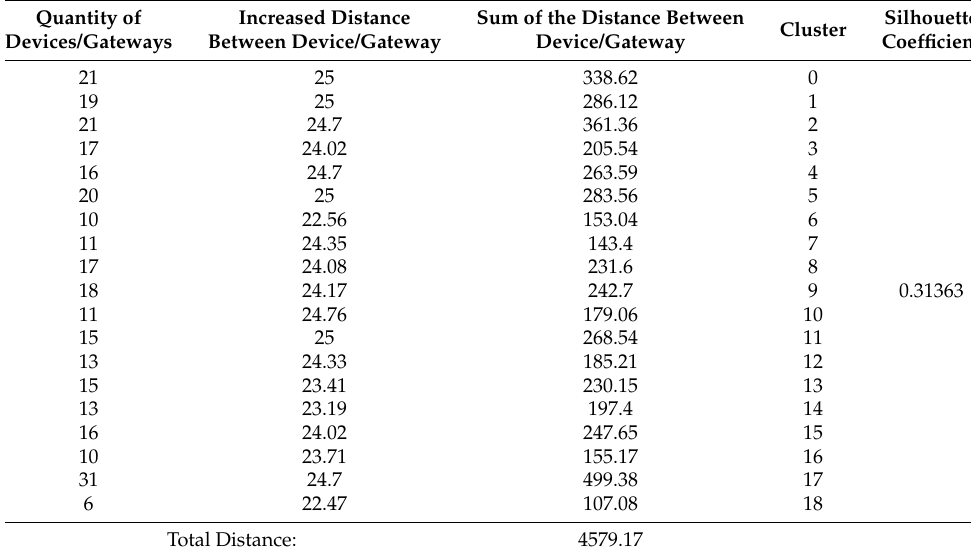
Table 10. The result of the gateway quantification experiments in the academic blocks scenario with 300 devices that were communicating via Wi-Fi technology, as presented in Figure 7b.